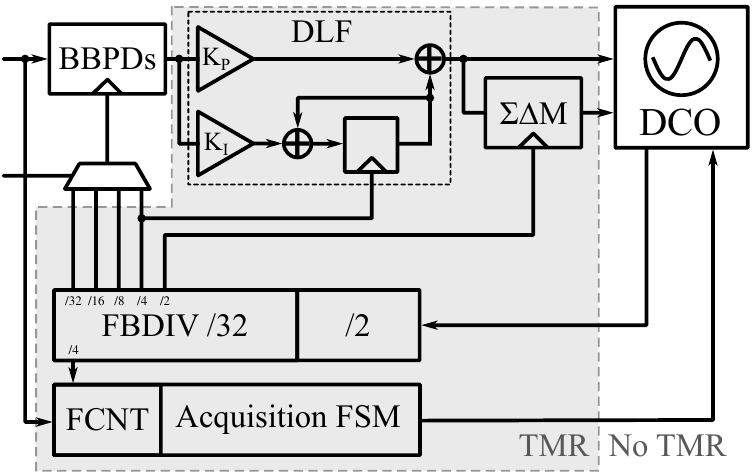
Figure 1. Architecture of the proposed All-Digital PLL/CDR circuit. All synchronous digital loop components are protected using TMR, only the DCO and BBPD remain without